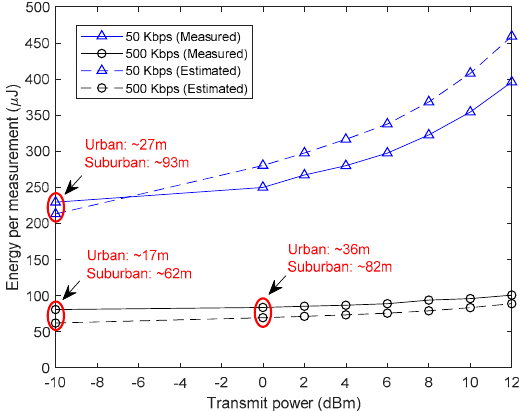
Figure 6. Estimated versus measured SN’s energy per measurement.